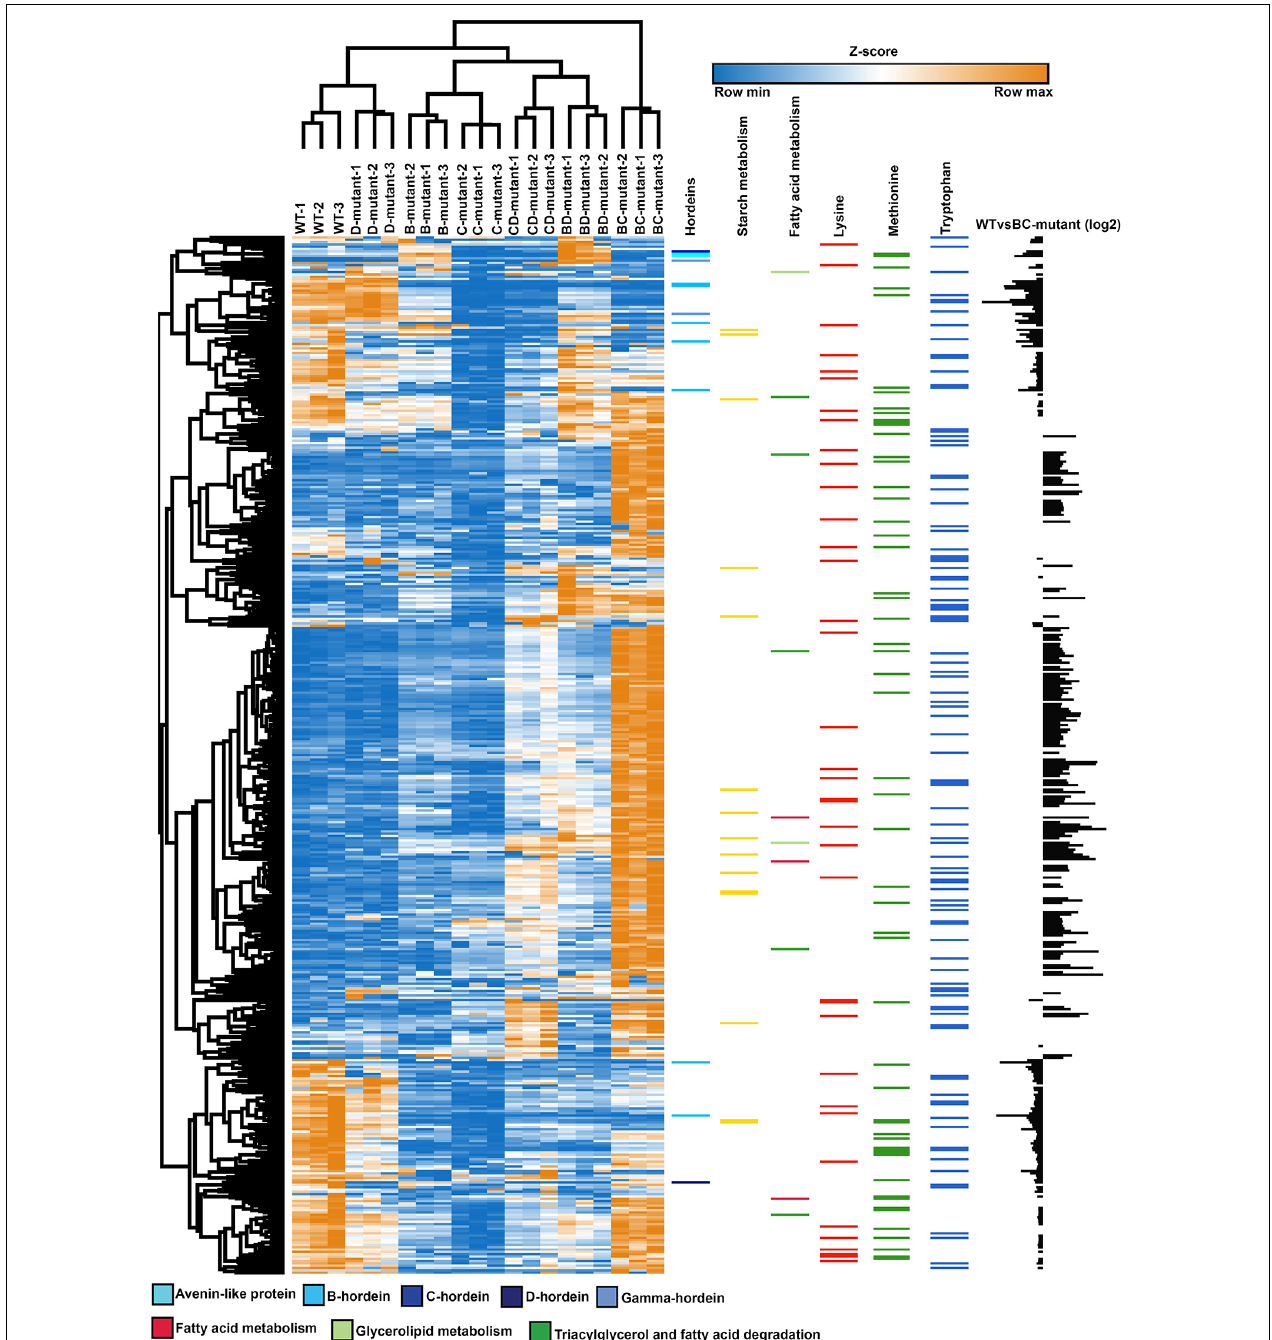
FIGURE 4 | Abundance profile of the chromosome mapped and differentially abundant proteins across the WT, single- and double-mutant lines. Heatmap showing the relative abundance levels (Z-scored) of proteins across the single and double-mutant barley lines in comparison to WT. Colour bars represent the abundance of hordeins, starch and fatty acid metabolism, lysine, methionine, and tryptophan-rich proteins. The individual amino acid contents were calculated using the Protein Report tool in CLC Genomics Workbench. The bar chart (last column) illustrates the log2 abundance of differentially abundant proteins in the WT and BC-mutant